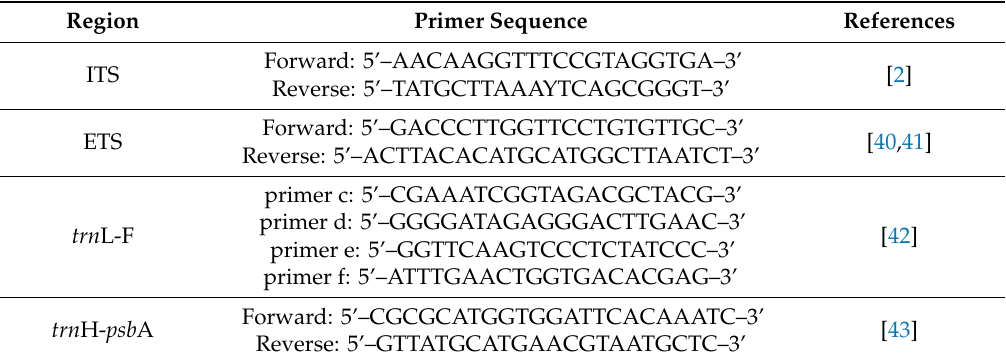
Table 3. Primer sequences used in the